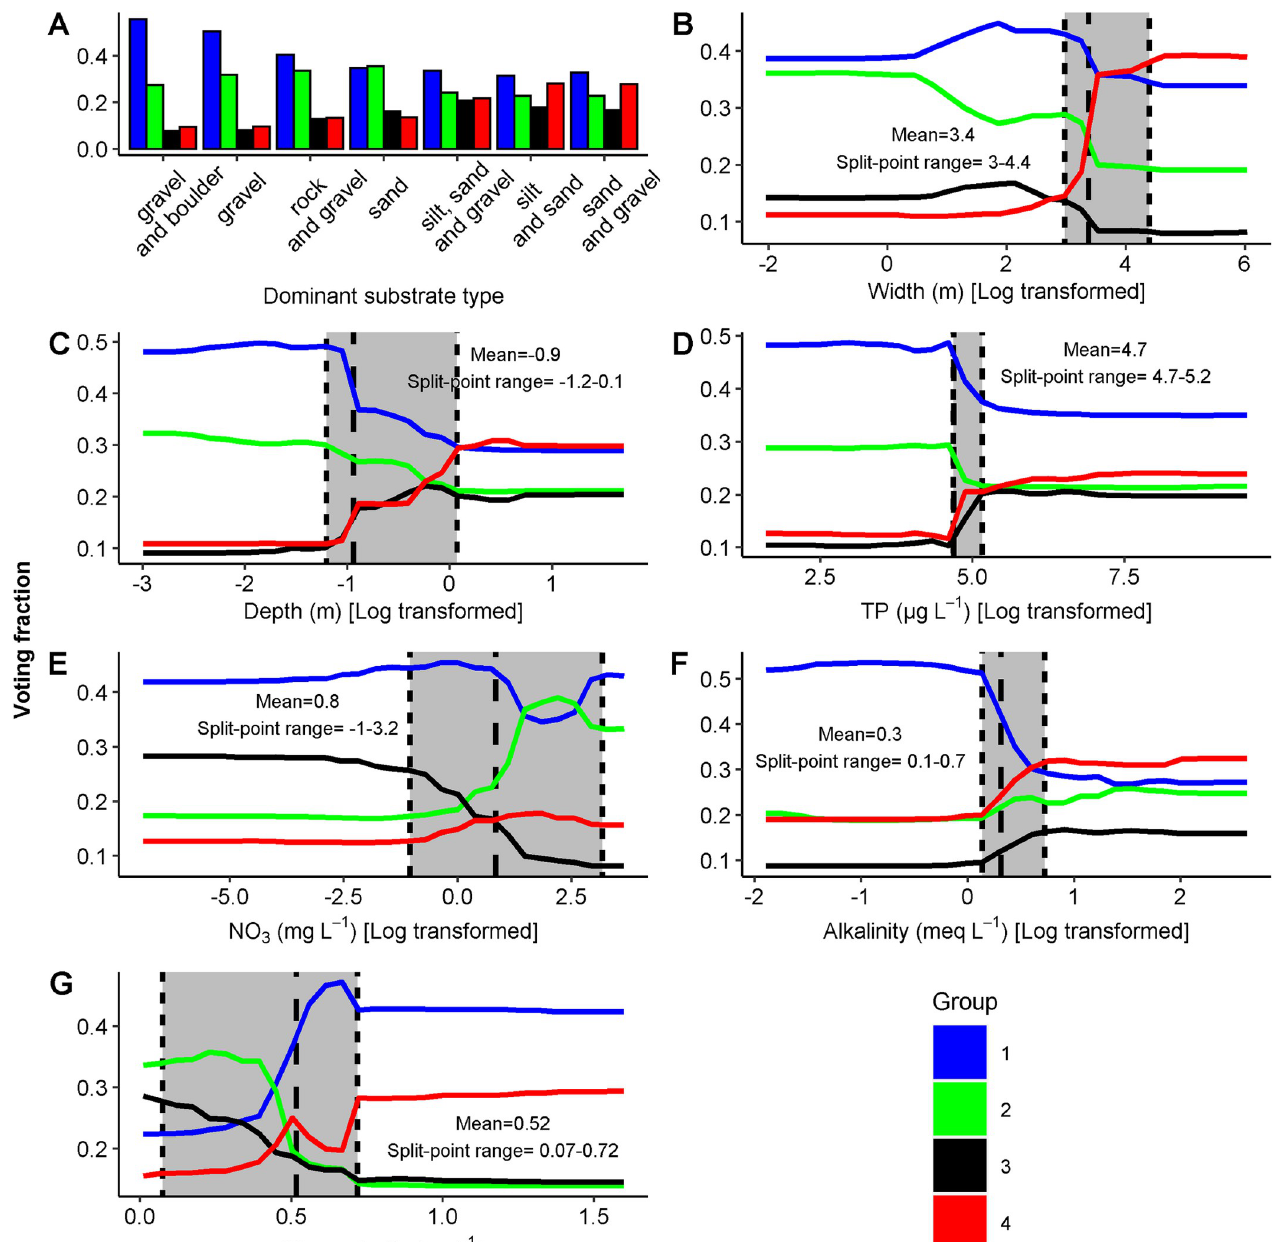
Fig 3. Partial dependency plots of Groups 1–4 displaying predictions of the RF model. A) dominant substrate type, B) width, C) total phosphorus, D) depth, E) alkalinity, F) nitrate and G) flow velocity. Grey coloured areas indicate the split-point range representing the minimum and maximum values extracted from the root-nodes for each generated tree. The two dotted lines indicate the minimum and maximum values and the dashed line indicates the mean. Variables are log-transformed for visualization (natural logarithm).